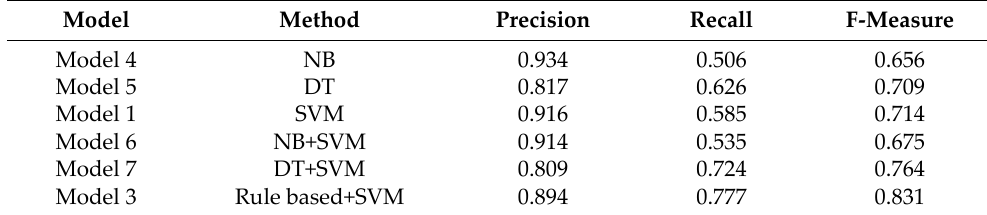
Table 6. Performance of different algorithm combinations.